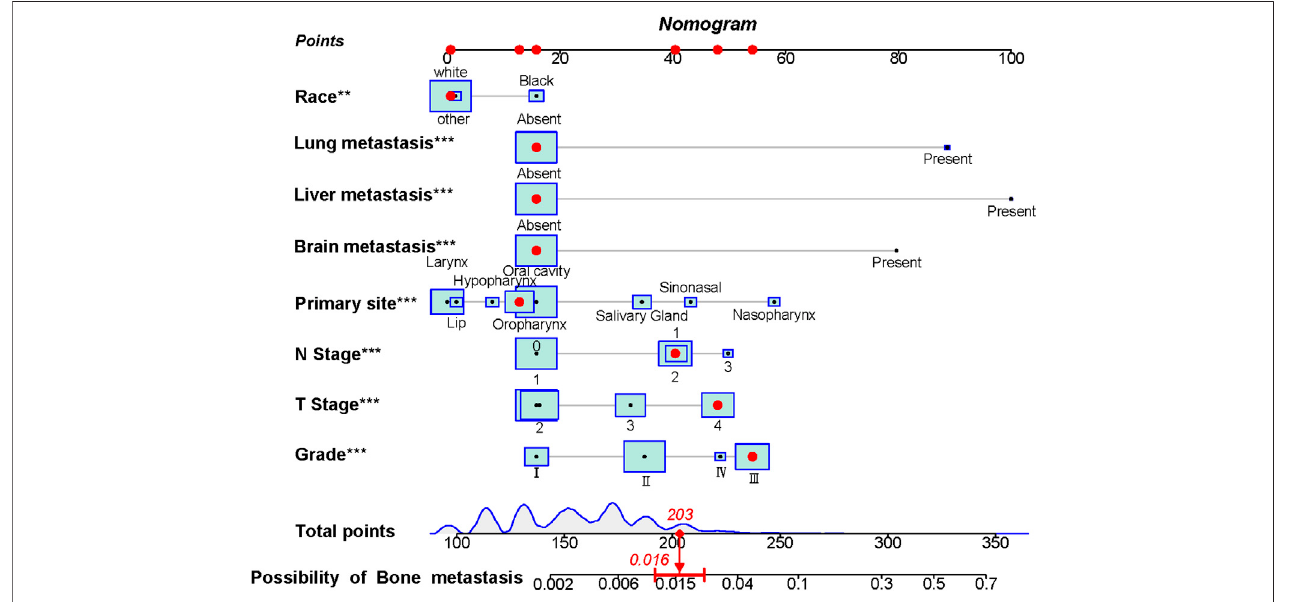
FIGURE 1 | The nomogram was used to predict the risk of bone metastasis in head and neck cancer patients. Each independent risk factor predicting the occurrence of BM in an individual patient is located on the left side of the nomogram, and its corresponding point is located on the variable axis above, with a line drawn upwardtothepoint axistodeterminethenumberofpointsassignedtoeachindependentriskfactor. Atotalpointlineislocatedatthebottomofthenomogram,andthe points correspondingtoeach independentvariable aresummedtogiveatotalpoint. Then, averticallineisdrawnfromthetotalpoint scaletotheBMaxis toobtain the probability of BM. For example, a patient of white race has no distant metastasis (liver, brain, lung), and the primary site is in the oropharynx with N1 stage, T4 stage, and Grade III. The corresponding total points of this patient ’ s is 1 (white race) + 16 (no lung metastasis) + 16 (no liver metastasis) + 16 (no brain metastasis) + 13